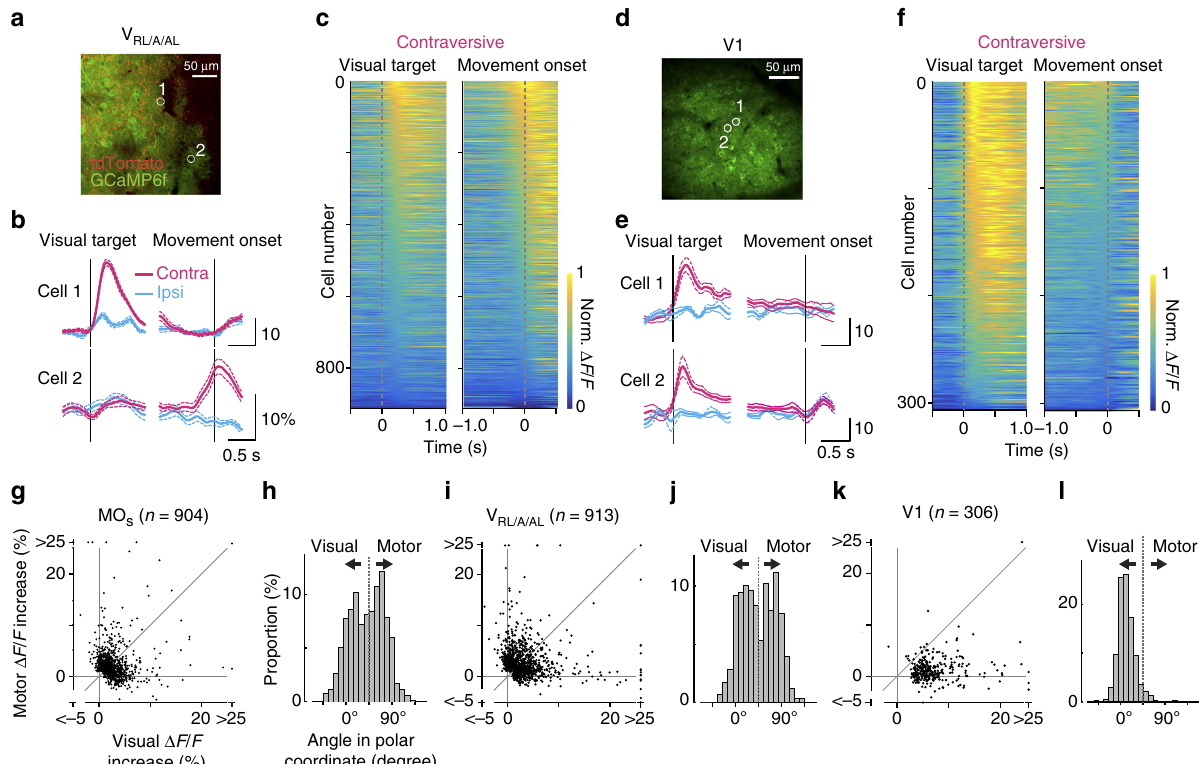
Fig. 5 Neural coding in the V RL/A/AL and the V1. a – c Coding in the V RL/A/AL . a GCaMP6f expression at layer 2/3 in the V RL/A/AL . The position of the V RL/A/ fl uorescent guidance of tdTomato-labeled projections from the MO AL was determined with s . b Representative cells. Corresponding ROIs are shown in a . c Sorted normalized Δ F / F responses for neurons showing signi fi cant response ( n = 913). Traces were aligned to either the onset of the visual target or the movement in the contraversive movement condition. d – f Coding in the V1. d GCaMP6f expression at layer 2/3 in the V1. e Representative cells. f Sorted normalized Δ F / F responses for neurons with a signi fi cant response ( n = 306). g – l Comparison between visual and motor activity for neurons in the MO s ( g , h , n = 904), V RL/A/AL ( i , j n = 913), and V1 ( k , l , n = 306). g , i , k Visual and motor activity was plotted for each neuron. h , j , l The angle in polar coordinates was computed for each neuron and plotted as a histogram. Degrees of 0 or 90 indicate pure visual or motor